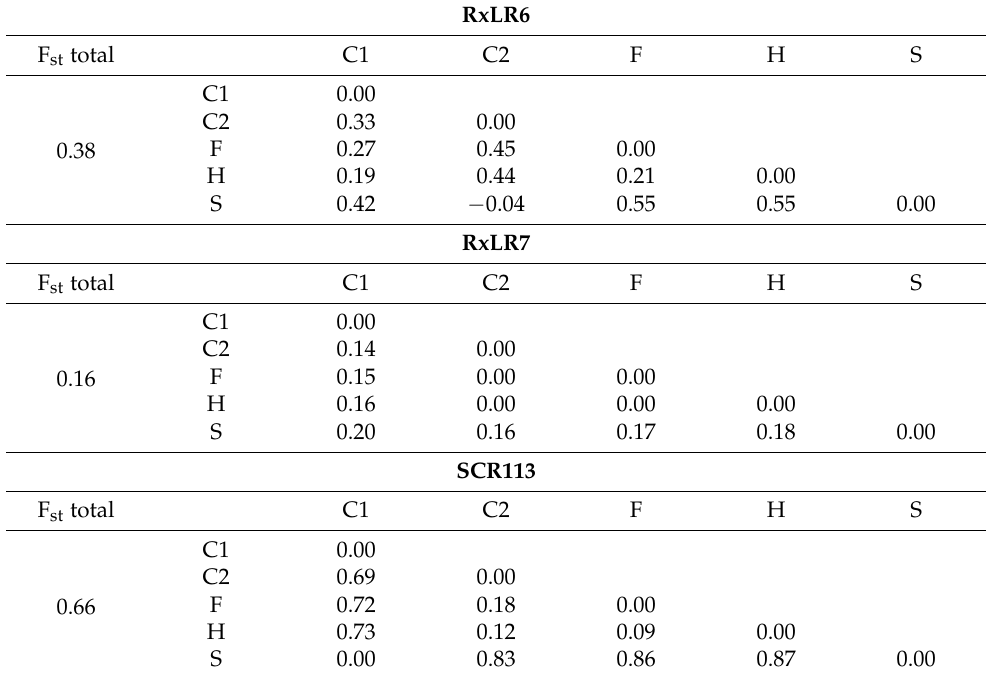
Table 6. The values of fixation index (F st ) calculated for three analysed effector genes RXLR6, RXLR7 and SCR113 for isolate groups C1, C2, F and H originating from woody hosts and the S group from strawberry plants.